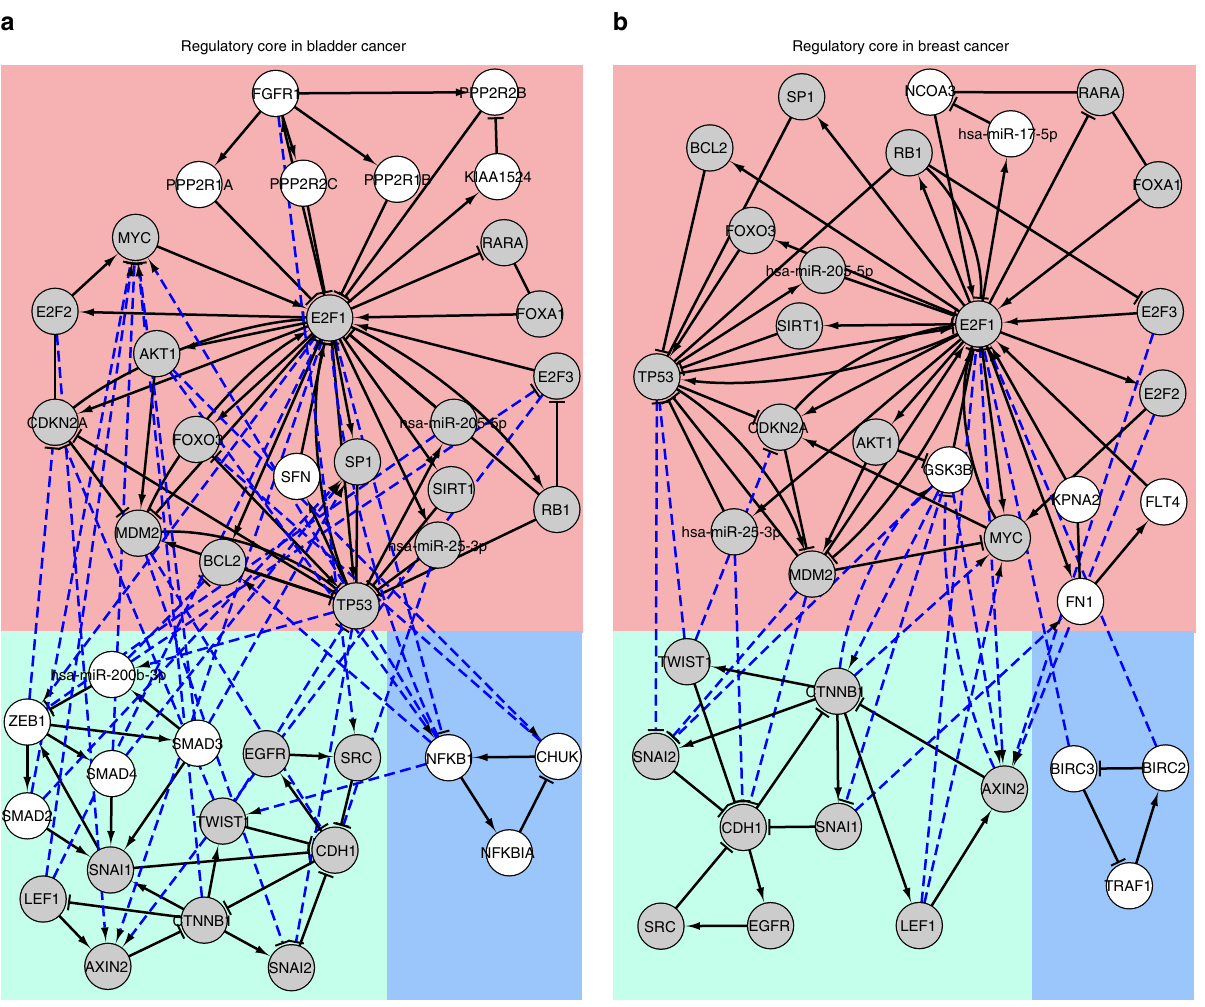
Fig. 3 Core regulatory networks that drive tumor invasiveness in a bladder and b breast cancer. The regulatory cores contain three disjoint sub-networks (shown in blue , pink , and green background colors ). Blue dotted lines represent direct interactions extracted from the comprehensive E2F1 regulatory network to interconnect these sub-networks. The networks were generated using Cytoscape plugin NetDS. Nodes in gray color are common in both regulatory core networks, whereas those in white color are